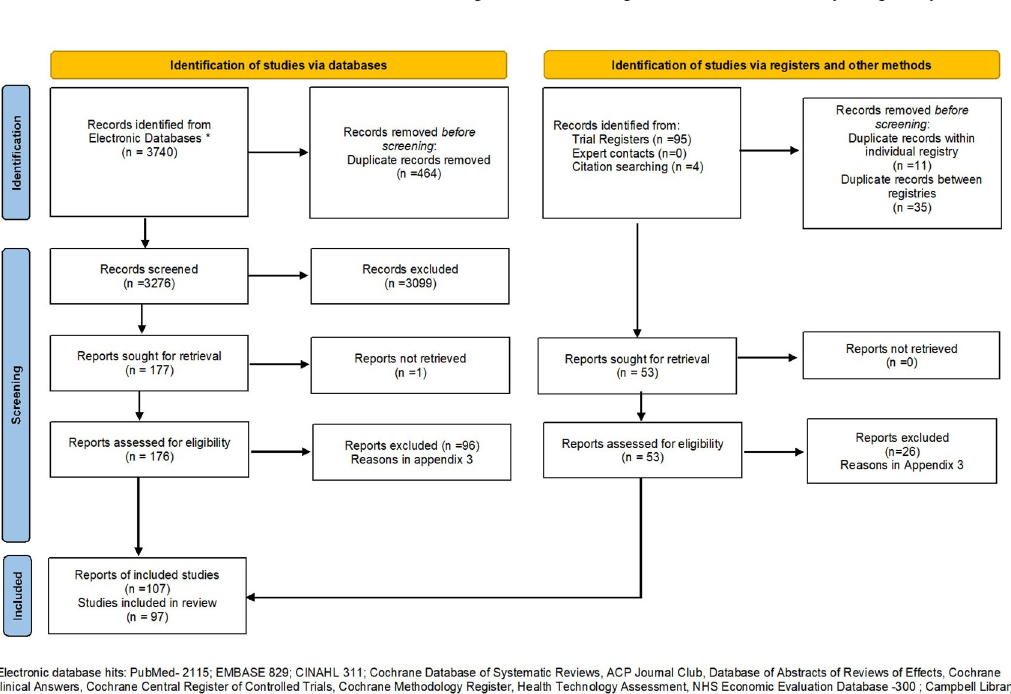
Figure 1. PRISMA flowchart showing selection of studies in the systematic